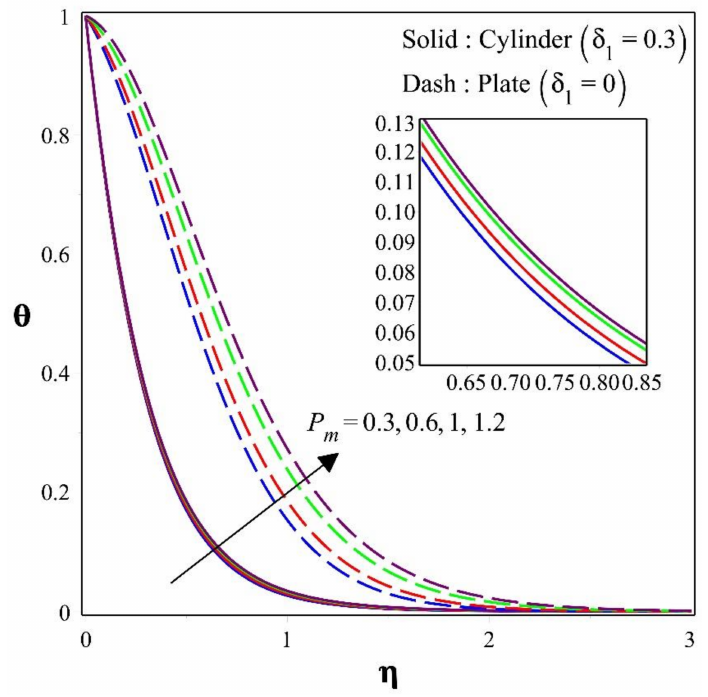
Figure 3. The role of porosity parameter on temperature profile (keeping γ 1 = 0.1, ζ = 30 0 , φ 1 = φ 2 = φ 3 = 0.01& H SS = 0.5).